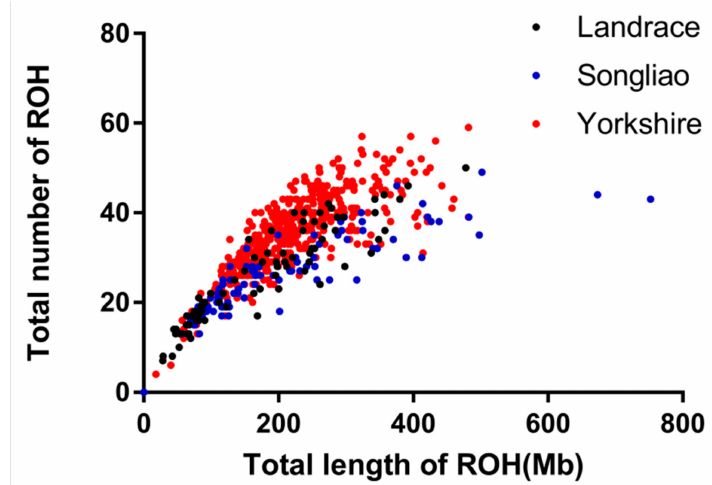
Figure 3. Total genomic length ( Mb ) covered by ROH per individual (x-axis) and total number of ROH per individual